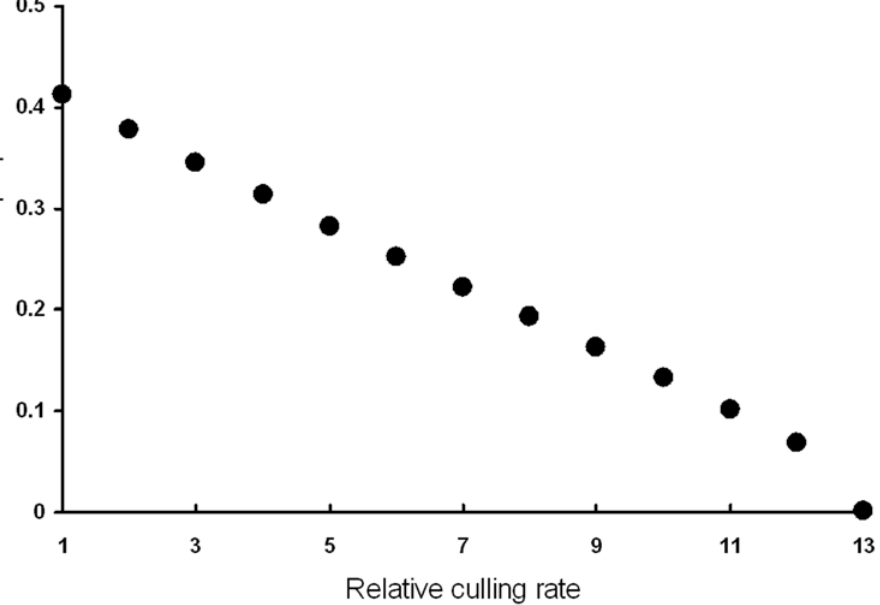
Figure 6. Decrease in the resistance allele evolved as the rate of selective culling increases. Selective culling hinders the evolution of host resistance to a much lesser degree than mass